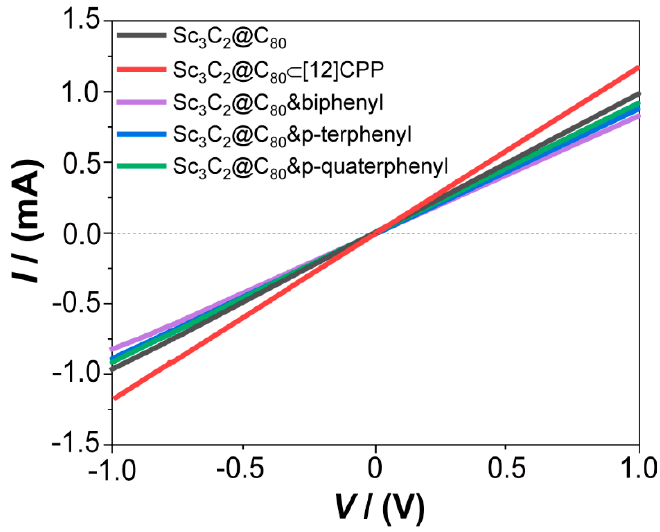
Figure 7. I–V profiles of Sc 2 C 2 @C 82 (black), Sc 2 C 2 @C 82 ⊂ [12]CPP (red), Sc 2 C 2 @C 82 &biphenyl (purple), Sc 2 C 2 @C 82 &p − terphenyl (blue), and Sc 2 C 2 @C 82 &p − quaterphenyl (green) with